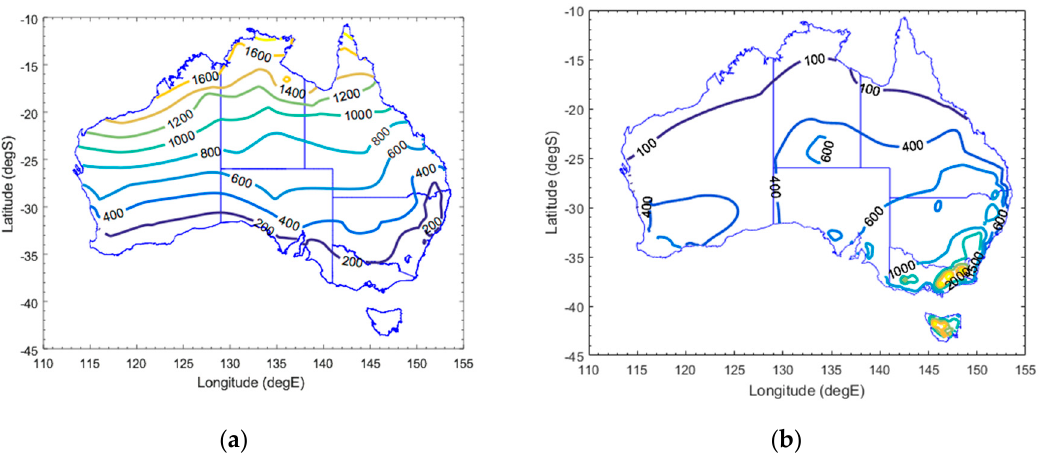
Figure 2. ( a ) Contours of cooling degree days and ( b ) heating degree days across Australia based on apparent temperature as calculated using 2011 Bureau of Meteorology (BOM) weather station measurements.